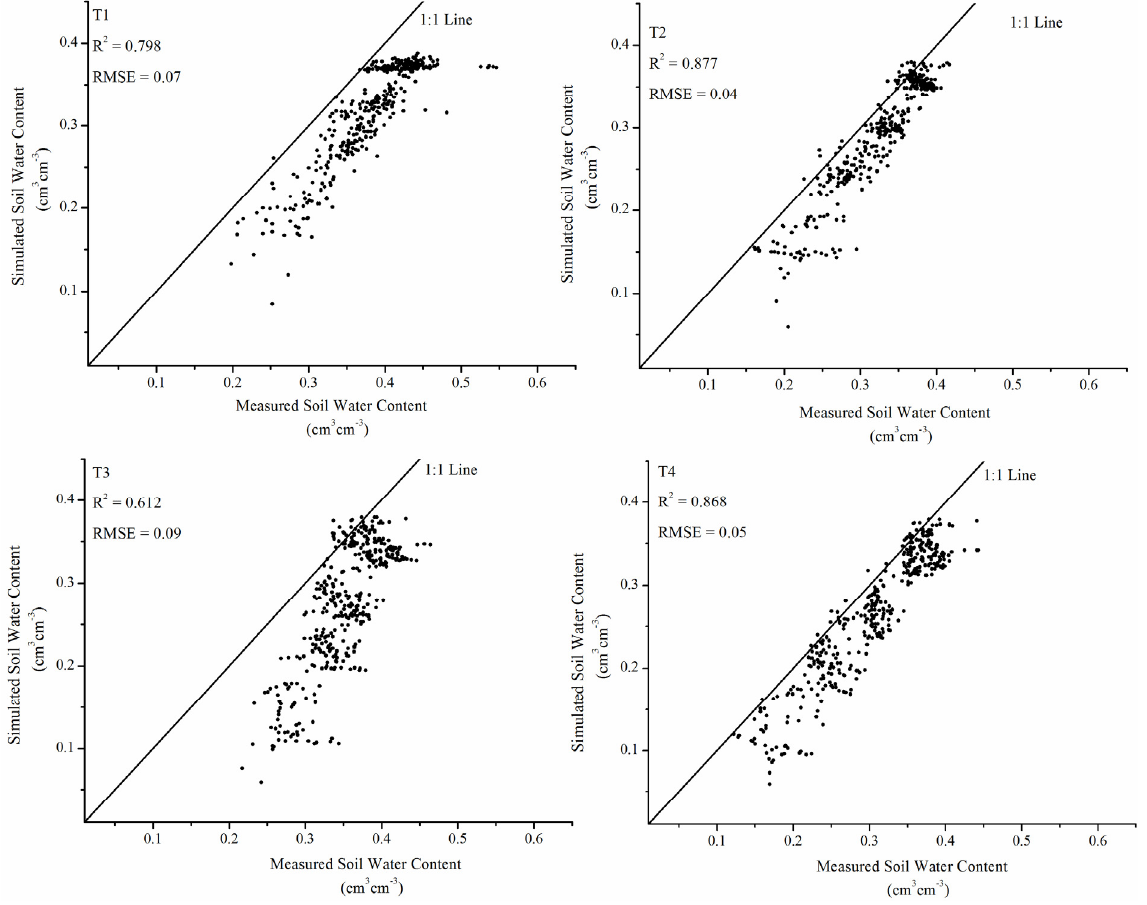
Figure 5. Comparison of the simulated and observed soil water contents of the four